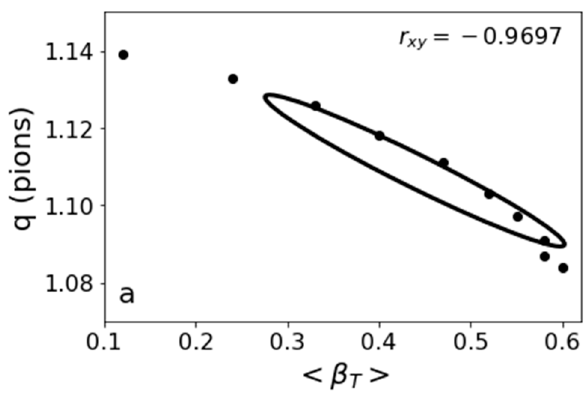
Figure 6. The q (pions) versus q (kaons) ( a ), q (pions) versus q ((anti)protons) ( b ), and q (kaons) versus q ((anti)protons) ( c ) dependencies, obtained using Equation (5) and presented in Table 2. The corresponding 1-sigma confidence ellipses and Pearson correlation coefficients are also shown in the figures.